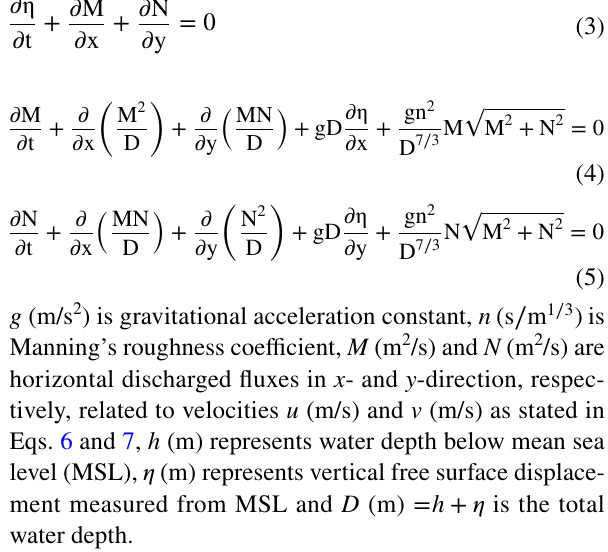
Fig. 3 Computational points for a staggered